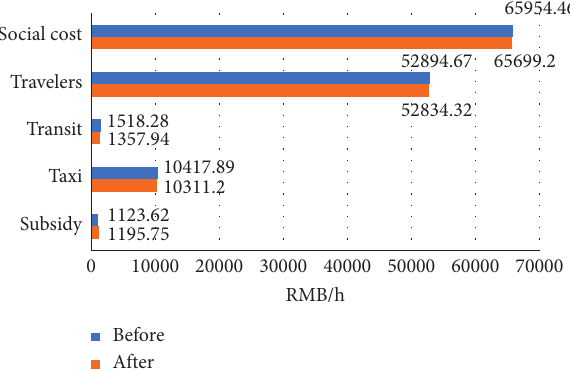
Figure 6: Upper-level social cost structure before and after the adjustment with the proposed versus 1195.75 RMB/h), and decreased cost (1518.28 RMB/h versus 1357.94 RMB/h).